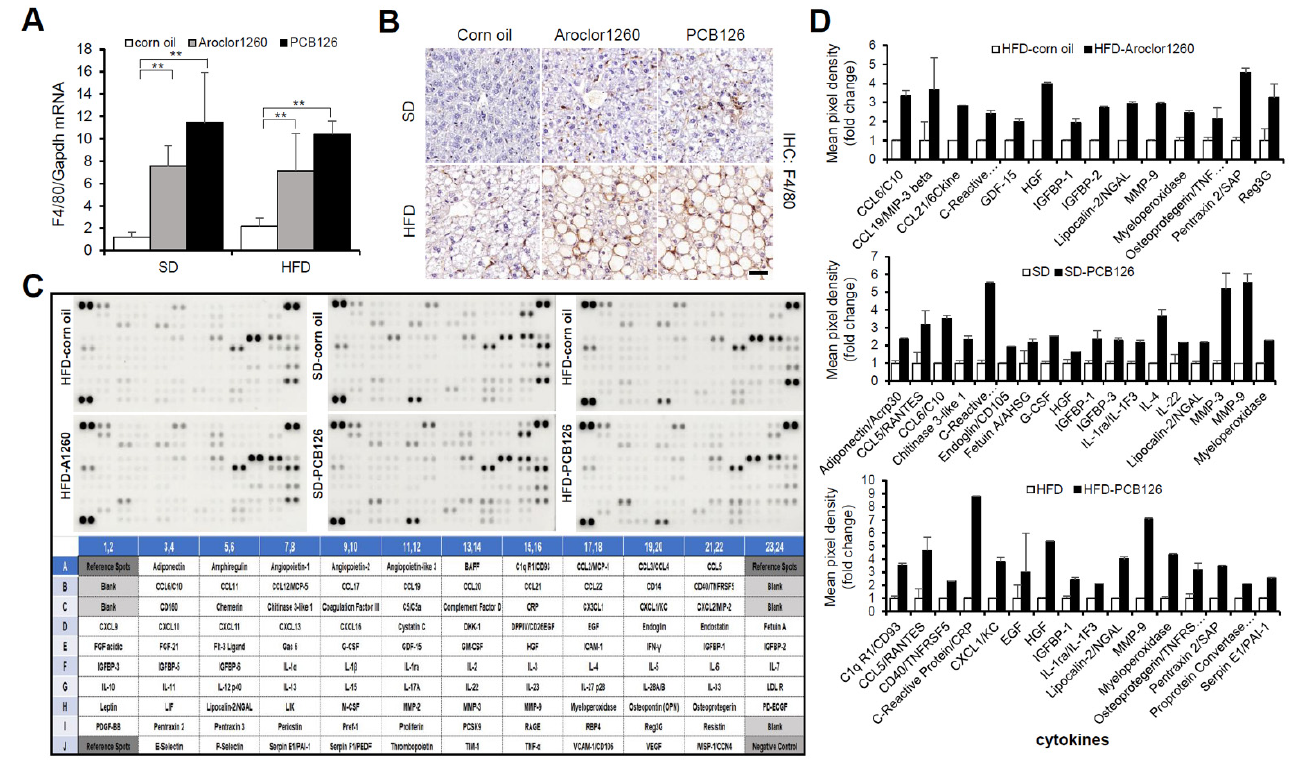
Figure 3. PCB exposure accelerates hepatic inflammation in PCB-induced NAFLD/NASH models. ( A ) Real-time PCR and ( B ) immunohistochemical staining were performed to detect mouse F4/80 in Aroclor1260- or PCB126-injected mice fed either a SD or HFD. Scale bar: 50 μ m. All values represent the mean ± SD, n = seven to nine mice per group. ** p < 0.01. ( C ) Representative images of cytokine array blots (upper panel) and the alignment of 111 cytokines in duplicates on a mouse XL cytokine array (lower panel). Each blot represents immunoreactive labeling against the respective antibodies. ( D ) Quantification of a mouse XL cytokine array showing that cytokines were significantly increased by Aroclor1260 or PCB126 in mice fed either a SD or HFD. n = 3.